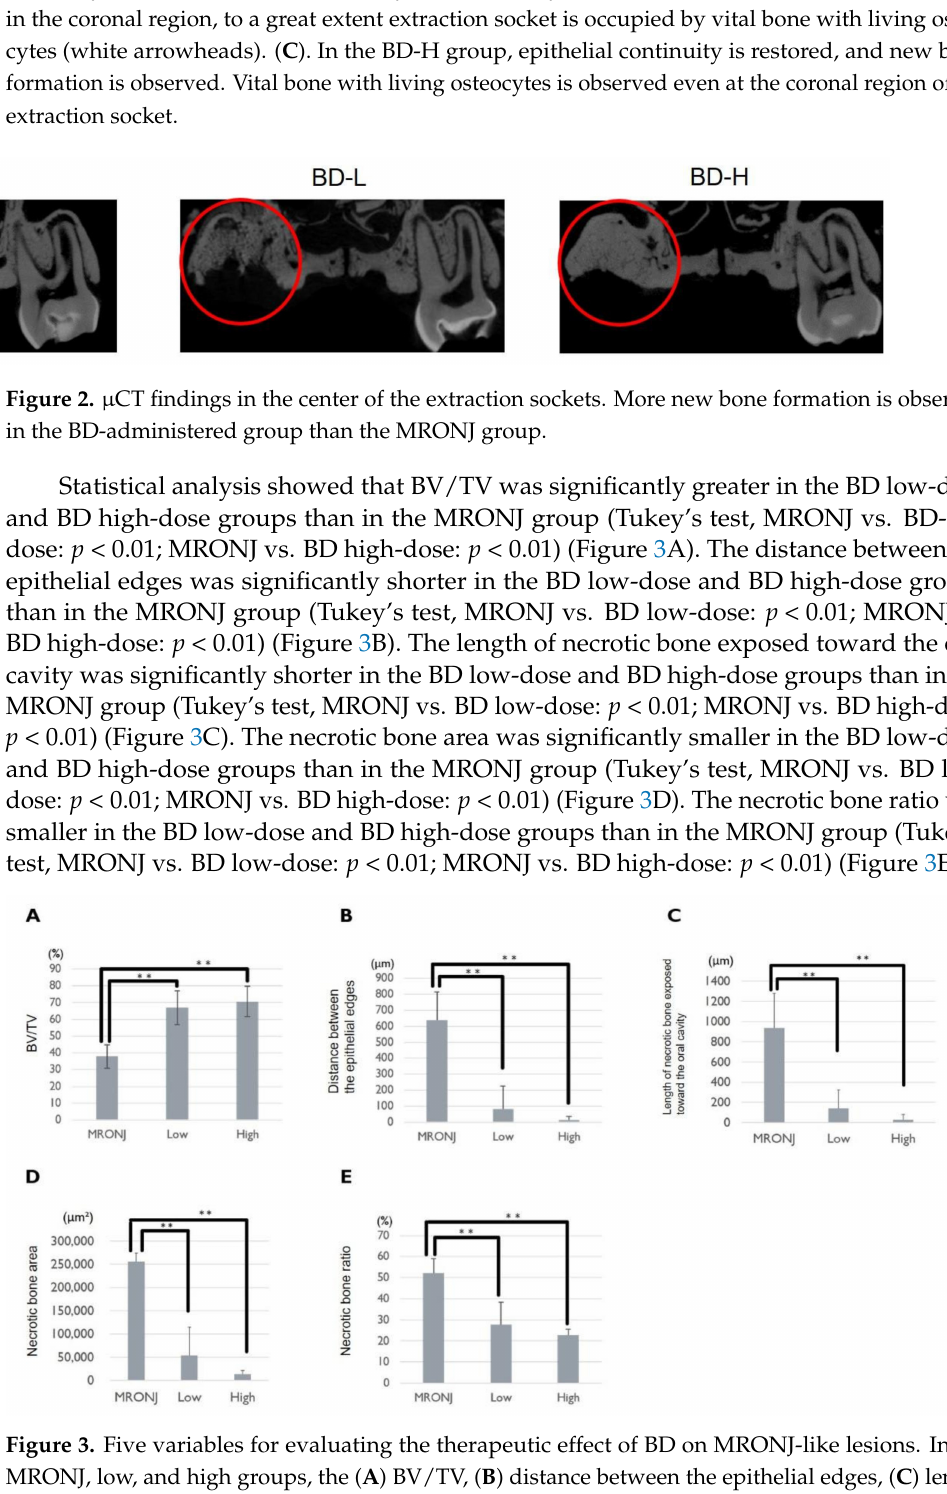
osteocytic lacunae (black arrowheads) is exposed at the coronal region (green square). At the periapi- cal legion, both necrotic bone (the area circled by dotted lines) and vital bone with living osteocytes (white arrowheads) are observed (black square). ( B ). In the BD-L group, epithelial continuity is restored, and new bone formation is observed. Although small amount of necrotic bone (the area circled by dotted lines) characterized by vacant osteocytic lacunae (black arrowheads) is observed in the coronal region, to a great extent extraction socket is occupied by vital bone with living osteo- cytes (white arrowheads). ( C ). In the BD-H group, epithelial continuity is restored, and new bone formation is observed. Vital bone with living osteocytes is observed even at the coronal region of the extraction socket.